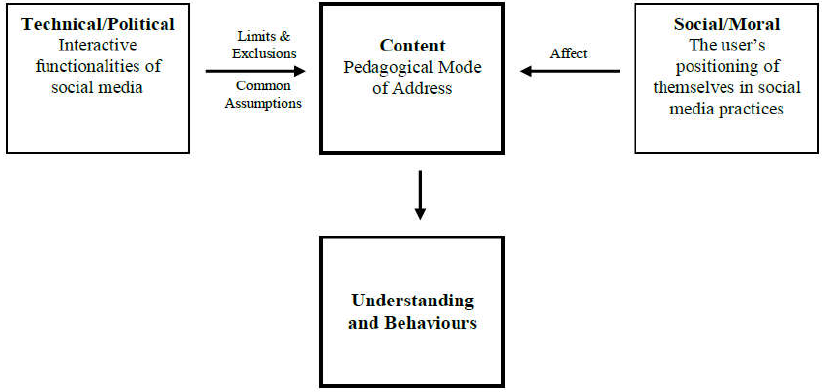
Figure 1. The operation of pedagogy in a social media context. (Goodyear et al. 2018a).